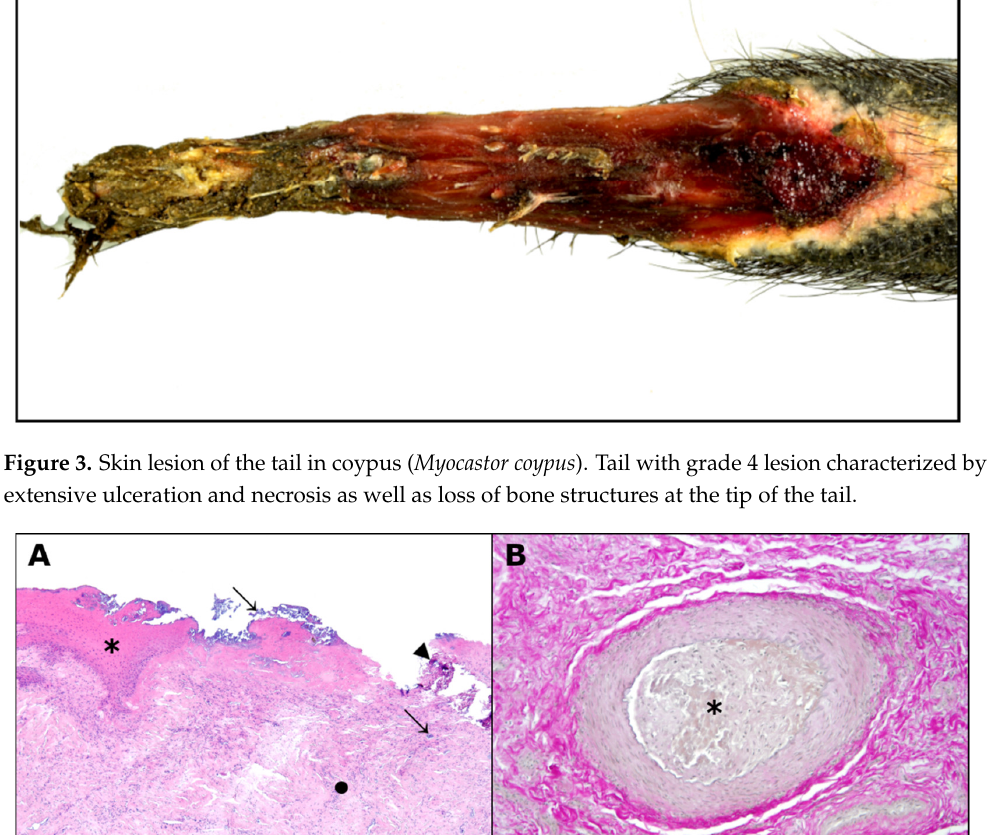
Figure 4. Cutaneous pathohistological findings in coypus. Severe extensive chronic ulcerative to sup- purative dermatitis with superficial bacterial colonies (arrows) and intralesional dystrophic minerali- zation (arrowead). Note the reactive peripheral epidermal hyperplasia (asterisk) and the underlying granulation tissue (black dot), hematoxylin and eosin ( A ). Magnification 40 × . Medium-sized cutane- ous arterial vessel with thrombus (asterisk), elastica van Gieson ( B ). Magnification 100 × .